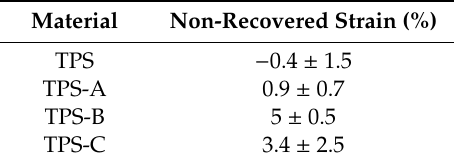
Table 3. Values of post-tensile non-recovered strain for pure TPS and its